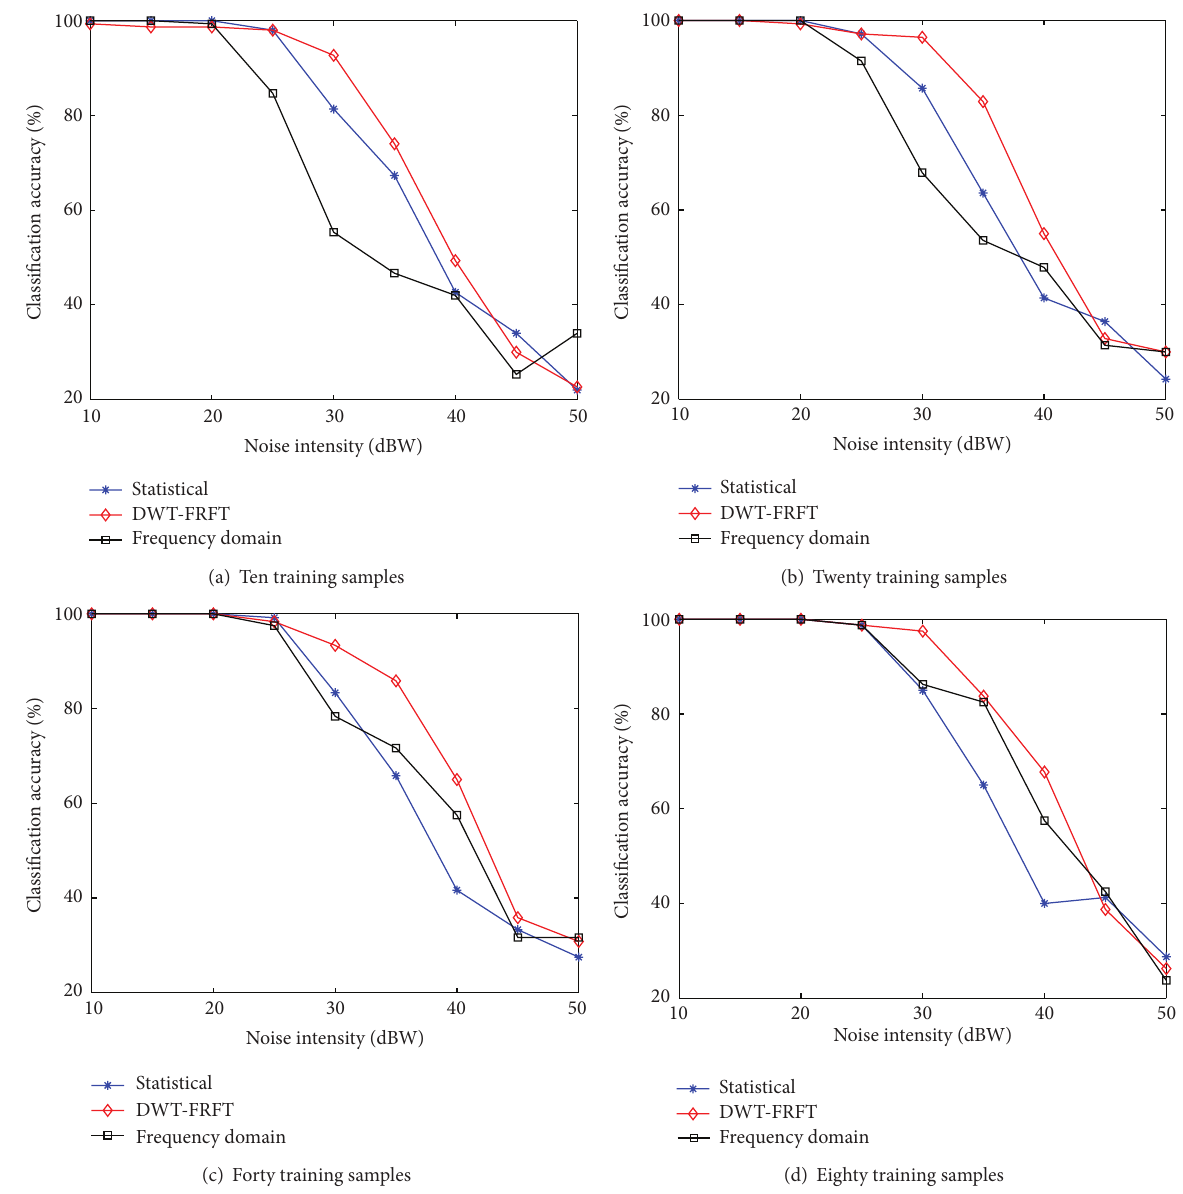
Figure 9: Classification accuracy of three features combined with SVM